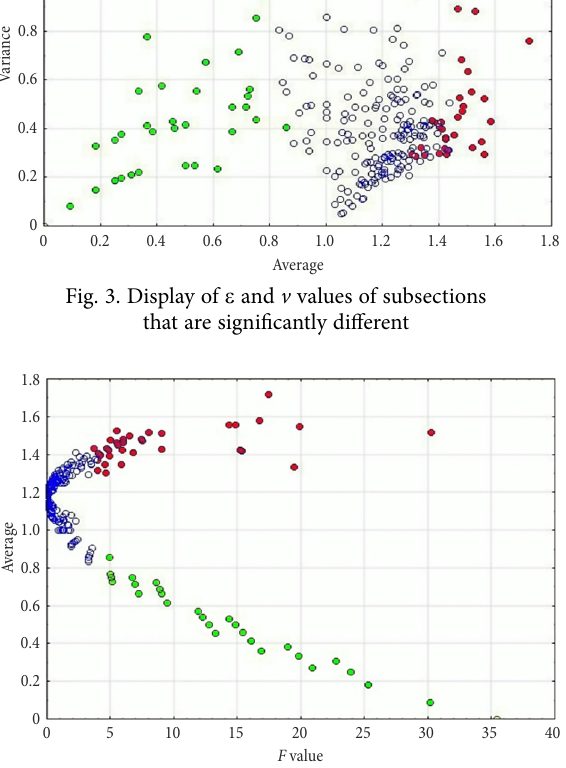
Fig. 4. Display of F and ε values of subsections that are significantly